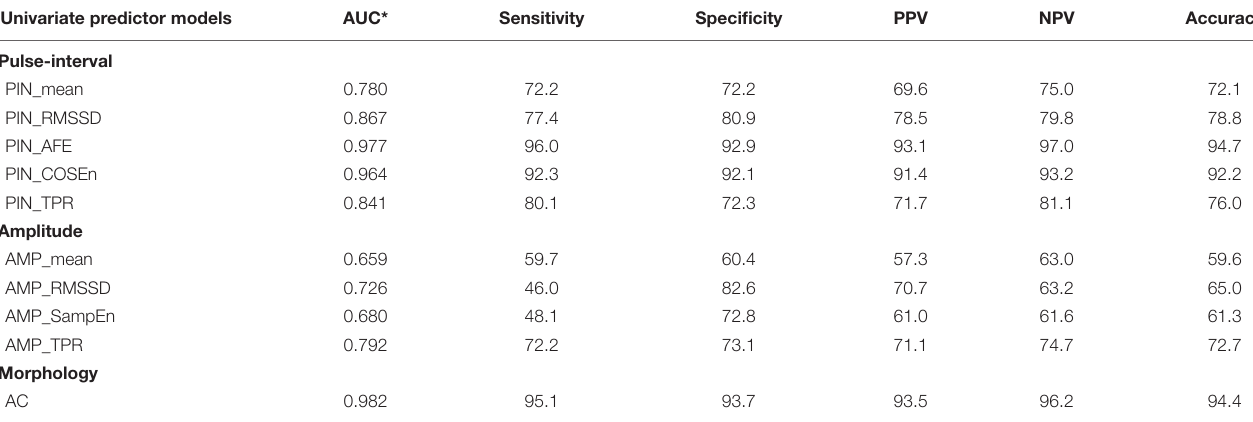
TABLE 3 | Averaged 10-fold cross-validated univariate predictor model diagnostic performance values for detection of atrial fibrillation. Univariate predictor models AUC* Sensitivity Specificity PPV NPV Accuracy